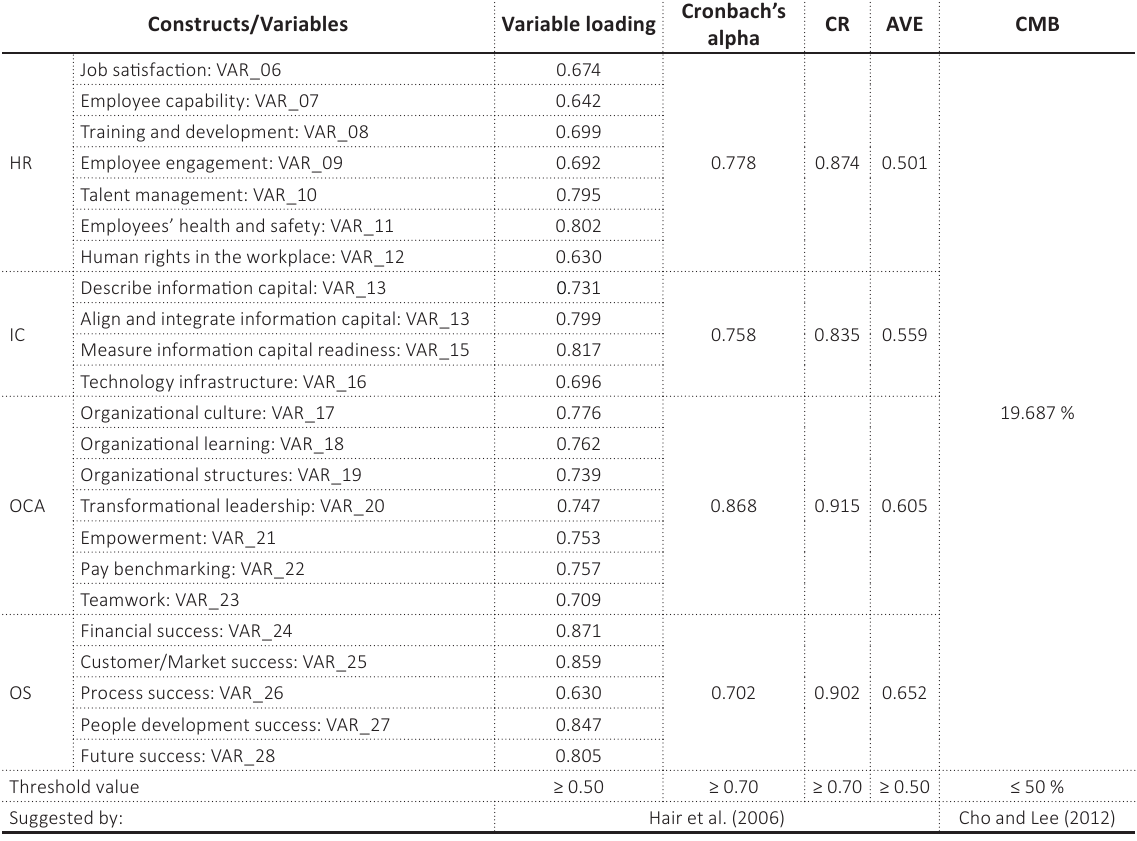
Table 3. Reliability, validity, and CMB insights